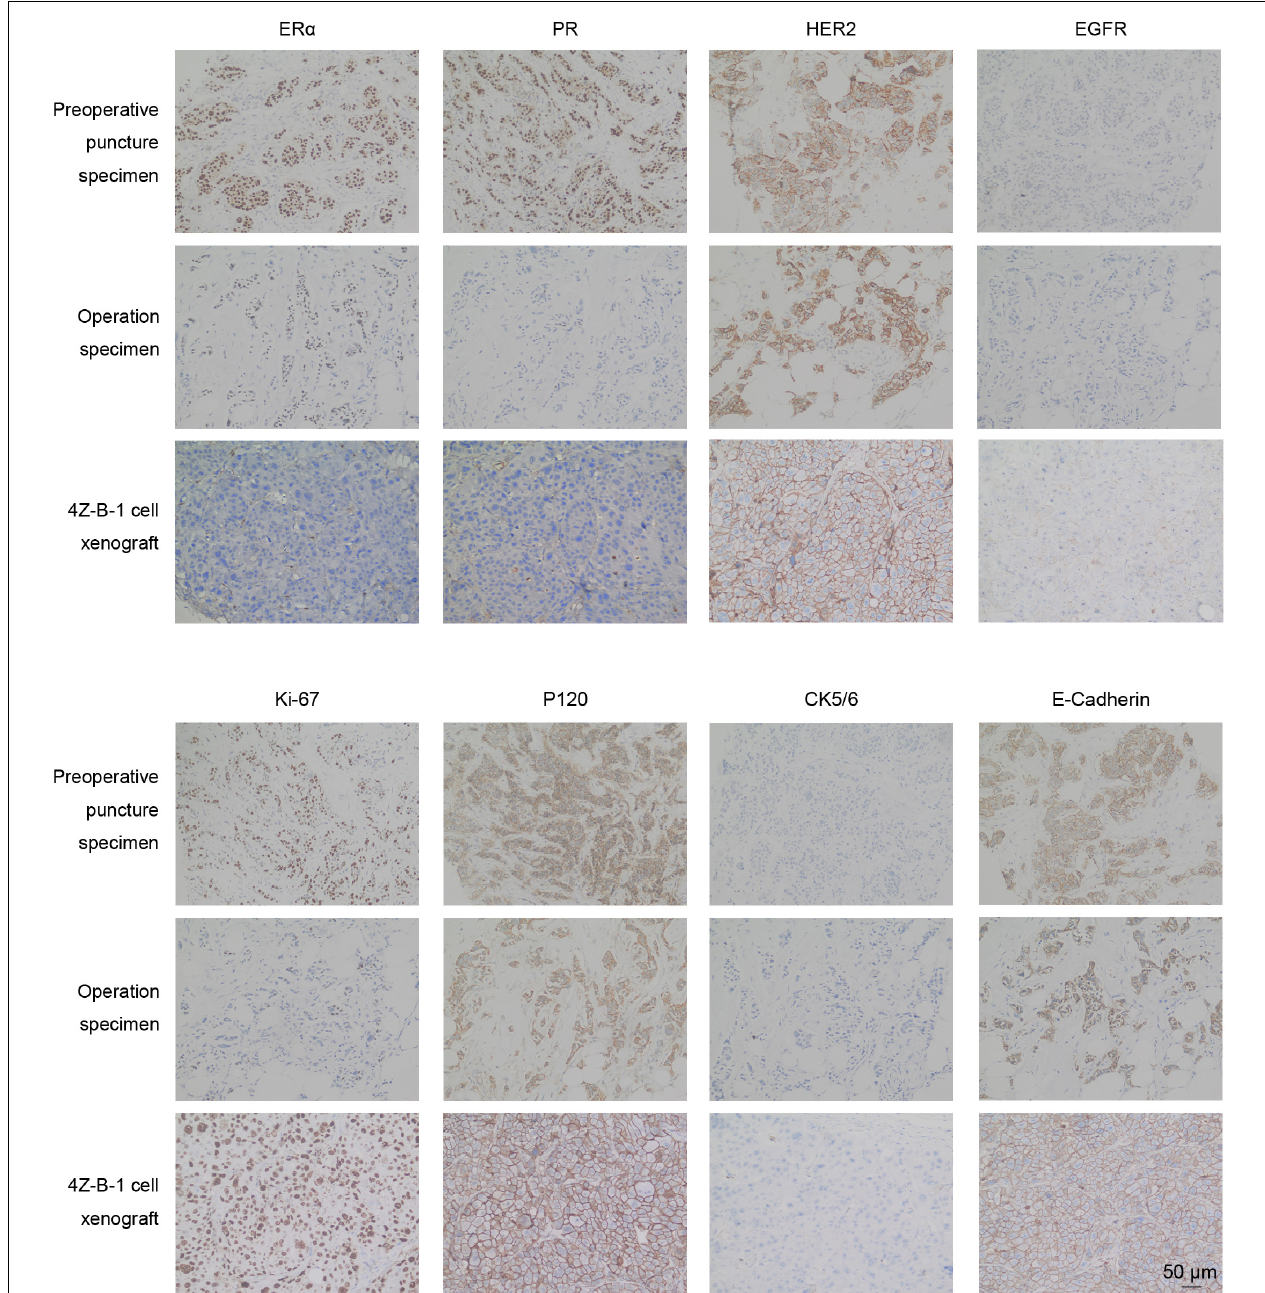
FIGURE 8 | IHC analysis of original and xenografted tumors. The expression of ER α and PR was decreased in 4Z-B-1 cell xenografts, while that of EGFR and Ki-67 was elevated. The expression of HER2, P120, CK5/6, and E-cadherin was similar in preoperative puncture specimens, operation specimens and 4Z-B-1 xenografts. Magnification: ×